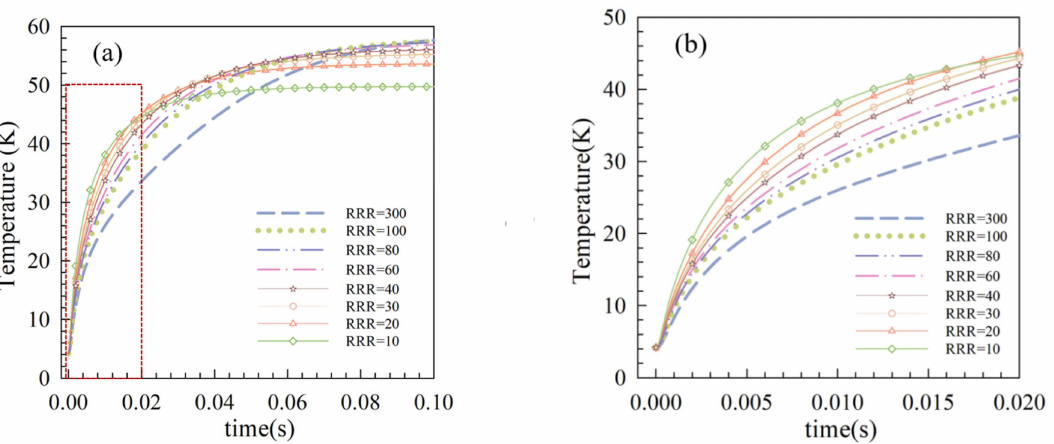
Figure 12. Average temperature of the copper discs during fast discharging tests. ( a ) during 0–0.1 s; ( b ) during 0–0.02